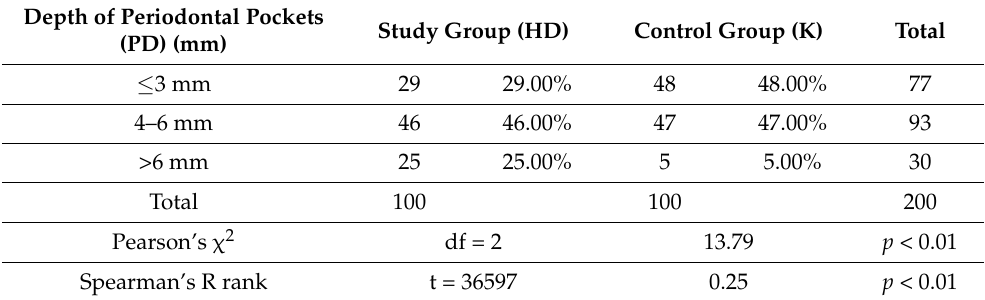
Table 2. Comparison of the distribution of periodontal pocket depths (PD) in both study groups (HD,